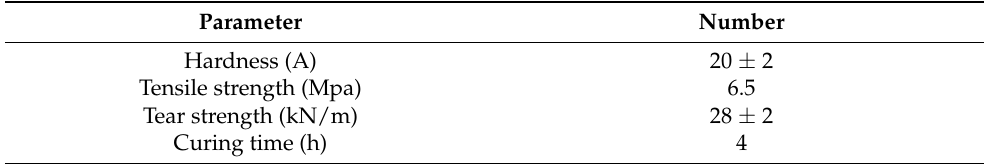
Table 1. E620A silica gel performance